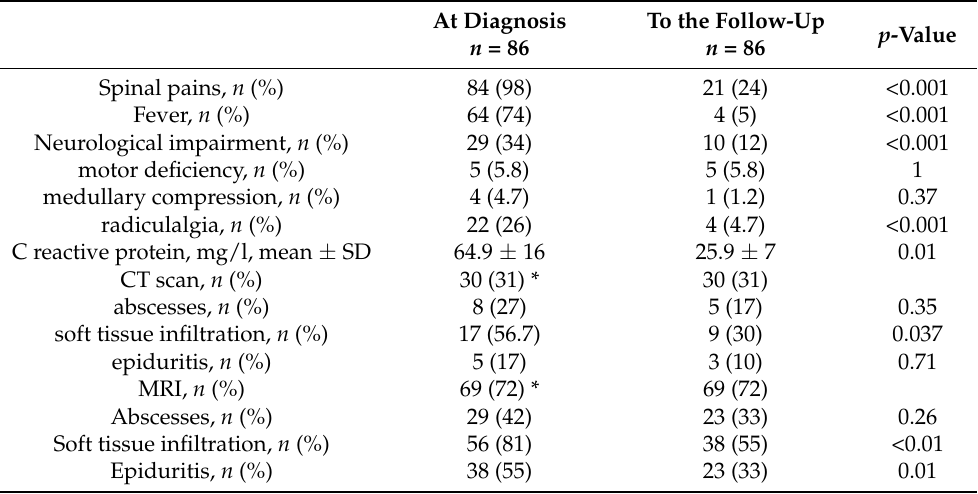
Table 2. Clinical, biological, and radiological imaging examinations